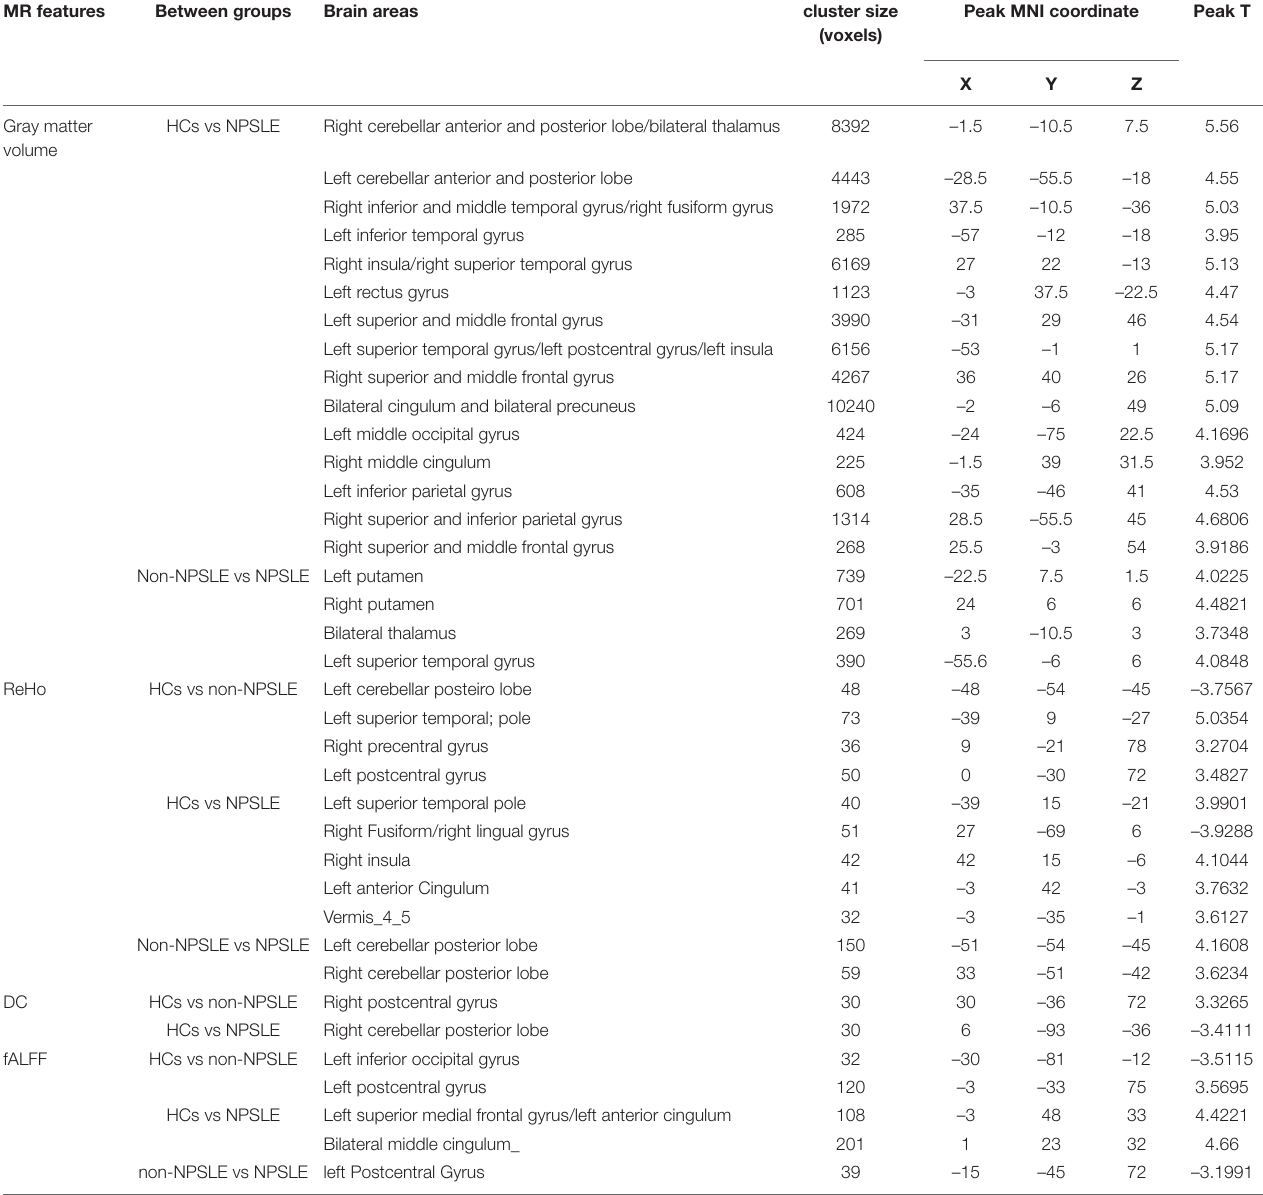
TABLE 2 | Statistically significant structural and functional alterations in SLE patients using voxel-based analysis. MR